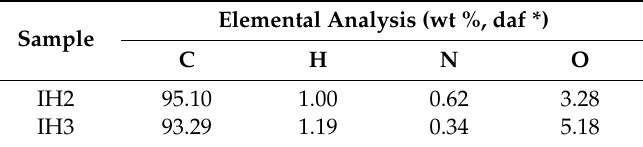
Table 1. Ultimate analysis of IH2 and